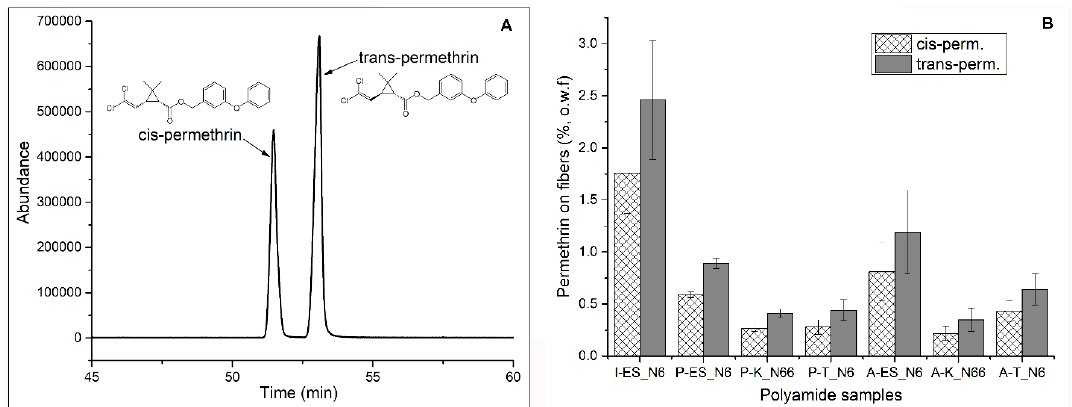
Figure 6. ( A ): GC chromatogram of cis- and trans-permethrin, and ( B ): Permethrin (Perm.) content (wt%, o.w.f., trans- and cis-permethrin) on polyamide fabrics after application (I—incorporation during fiber formation, P—plasma-treated, and A—as-spun/received, untreated samples). Table 4. Wet pickup efficiencies of permethrin on the polyamide fabrics. (nylon 6 nanofibers (ES_N6) , nylon 66 Knit (K_N66), nylon 6 tricot (T_N6), I—incorporation permethrin during fiber formation, P—plasma-treated, and A—as-spun/received, untreated samples). Samples